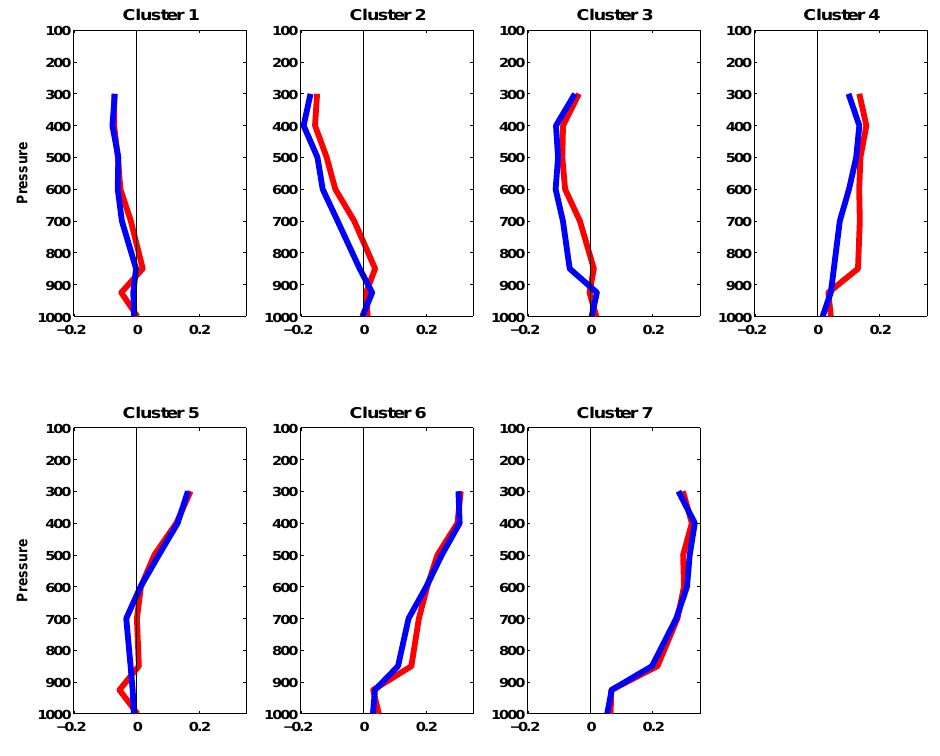
Fig. 15. As in Fig. 14, except for relative humidity anomalies. Table 7. Average LWCRF from cloud fraction change, LWCRF from emissivity change, and LWCRF from cloud-top pressure change for the difference between the warm and cold subsets (per degree temperature change; Subsets different at the 95% confidence level are in